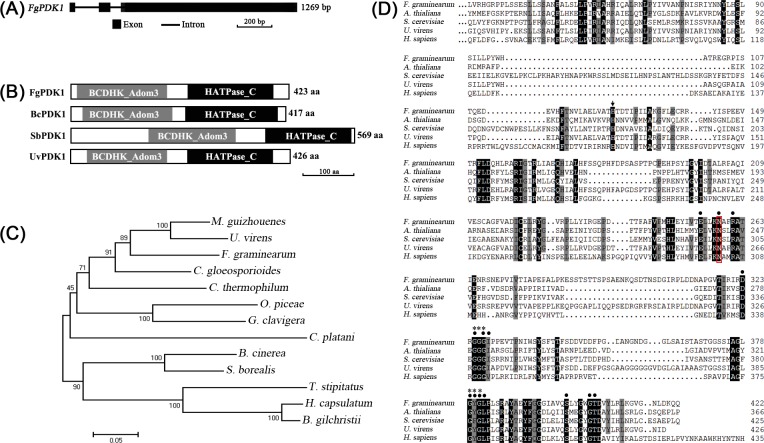
Sequence analysis of FgPDK1.(A) Structure of nucleic acid sequence of FgPDK1. (B) Analysis of conserved domains in FgPDK1 and its homologues from other fungi. (C) The phylogenetic analysis of PDK1s from different fungi. The phylogenetic tree was constructed using the Neighbour-Joining method. Evolutionary analyses were conducted in MEGA4. (D) The multialignment of PDK1 from F. graminearum, A. thialiana, S. cerevisiae, U. virens, and H. spiens. Dark shading with white letters and grey shading with black letters indicate 100% and 75% sequence similarity, respectively. The black dot indicates ATP binding site. The asterisk indicates G-X-G motif. The red box indicates Mg2+ binding site. The black arrow indicates conserved His working for phosphotransfer.